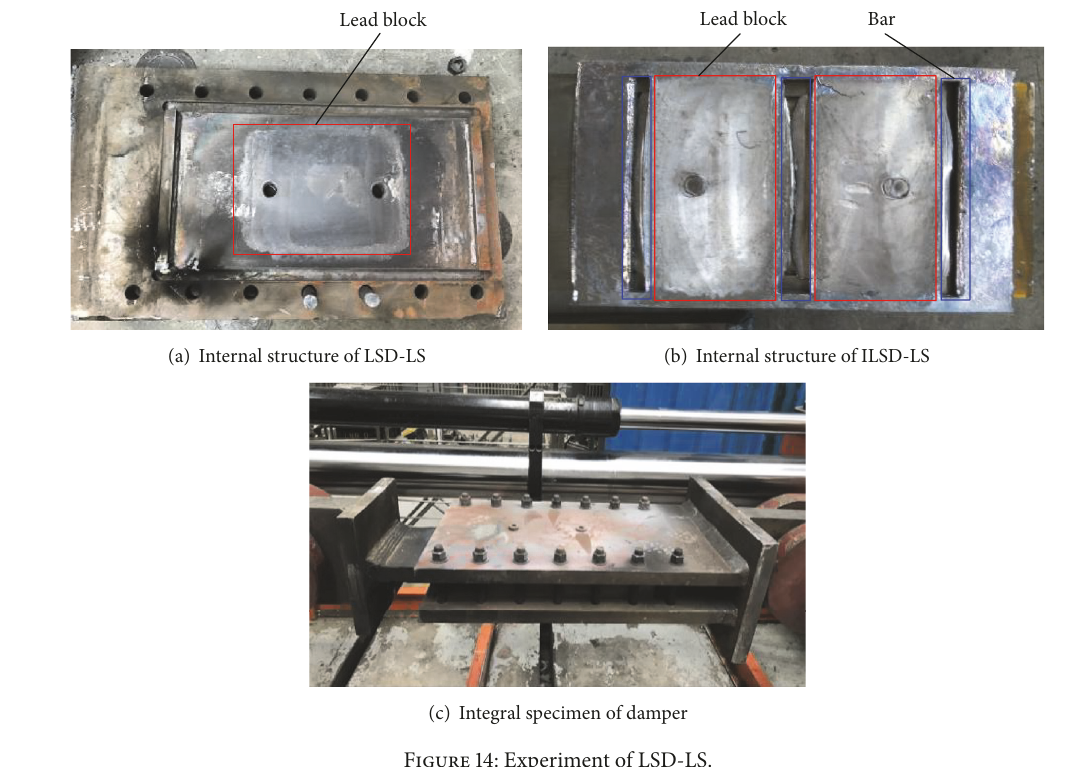
Figure 14: Experiment of LSD-LS.